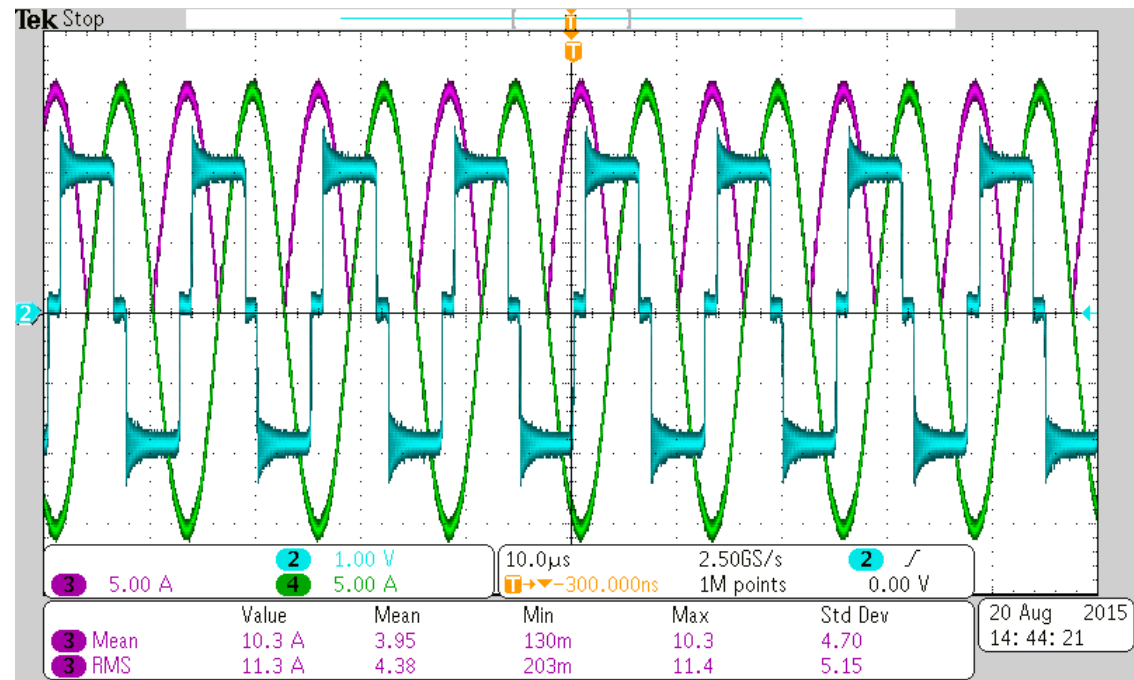
Figure 20. Critical waveforms when there is no filter capacitor in the